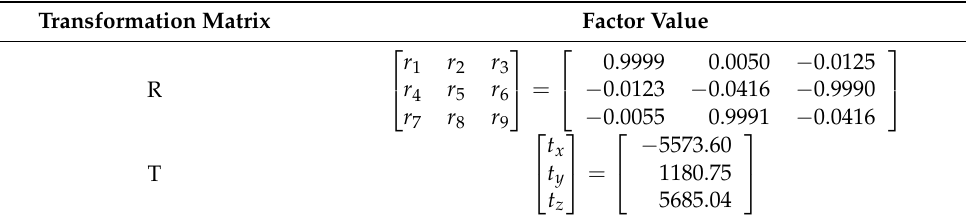
Table 4. Transformation matrix between camera and world coordinate